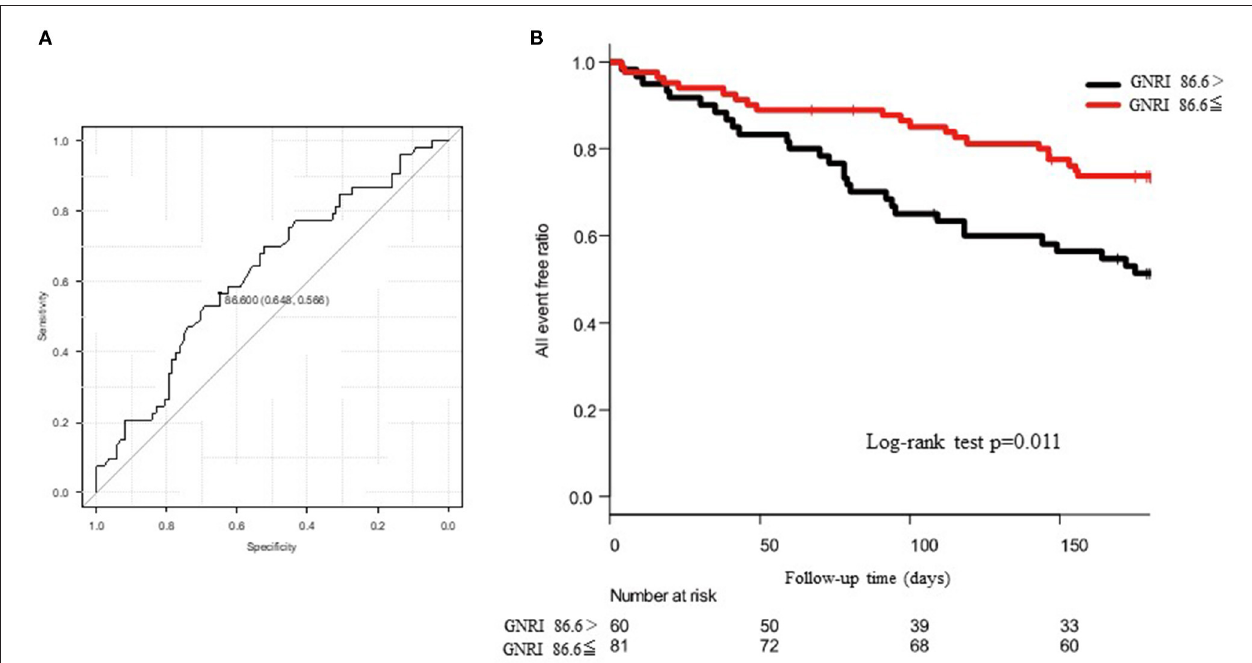
FIGURE 4 | (A) shows the receiver operating characteristic (ROC) curve to predict the cut-off value of composite endpoints using the geriatric nutritional risk index (GNRI). The area under the curve (AUC) was 0.625 and 95% CI was from 0.530 to 0.721. When the cut-off value of GNRI was set to 86.6, the sensitivity and the specificity became 65 and 57%, respectively. (B) shows the Kaplan–Meier curve to evaluate the cumulative incidences of composite endpoints. The log-rank test revealed a p -value of